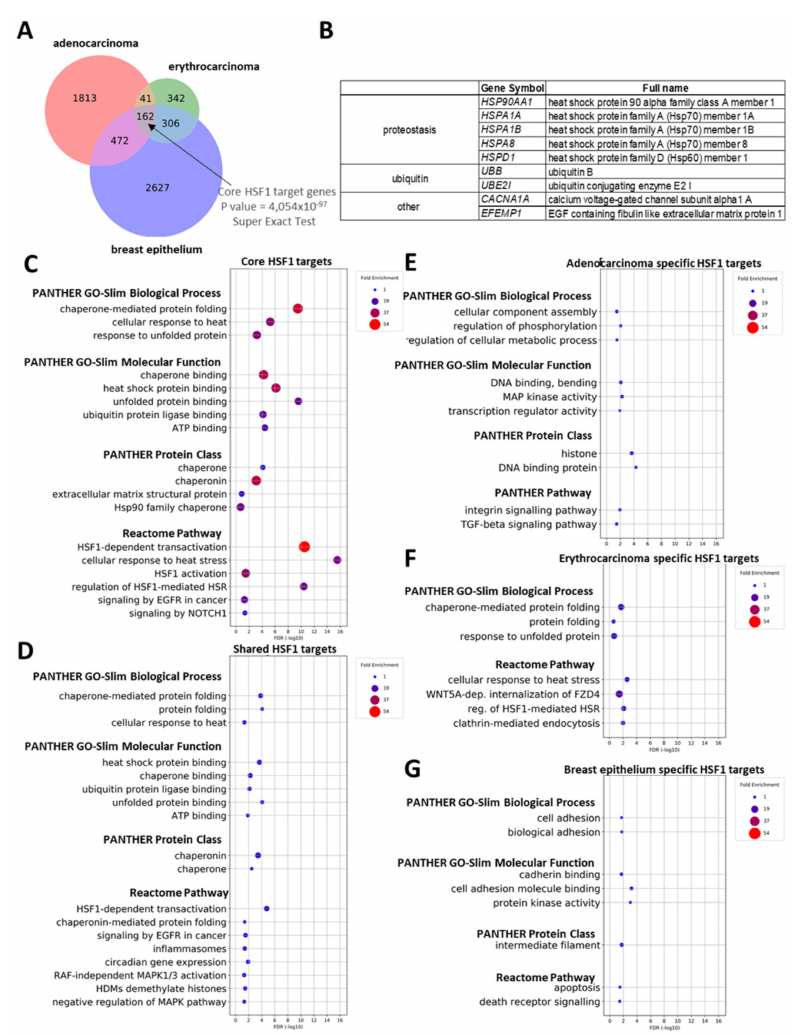
Figure 2. HSF1 transcription factor binds tissue-specific and shared targets in human. ( A ) Venn diagram depicting overlaps between HSF1 target genes in all cell types analysed ( p = 4.05 × 10 − 97 , super exact test; 19,608; all human genes were used as a background); ( B ) HSF1 target genes involved in ageing